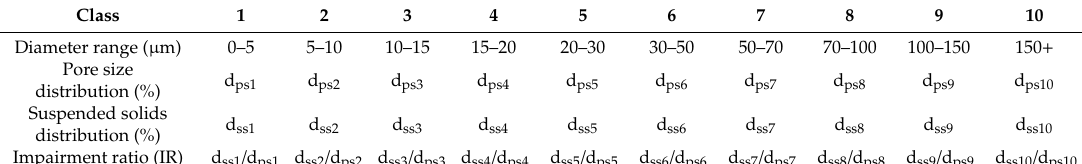
Table 1. Classification of suspended solids / pore size with impairment